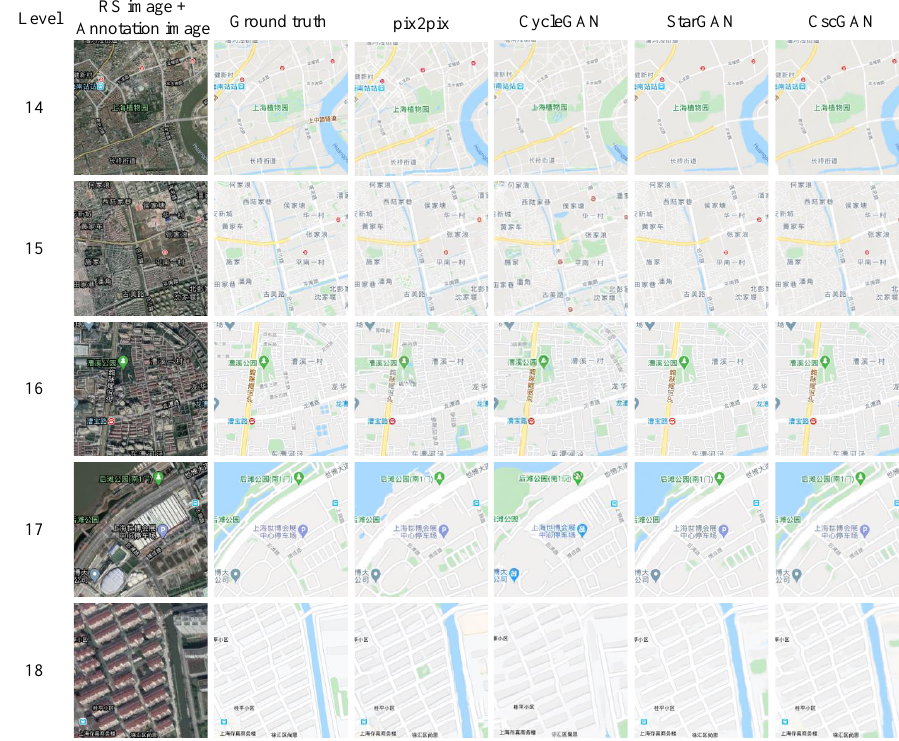
Figure A1. Example results translated by different